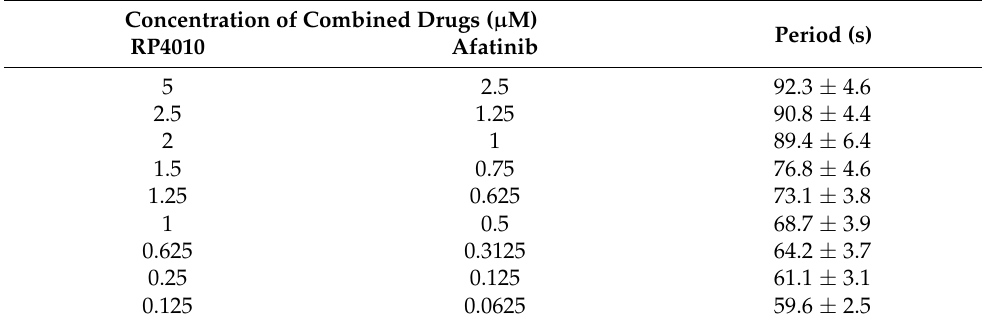
Table 4. Effects on intracellular Ca 2+ oscillations by combined RP4010 and afatinib (experimental